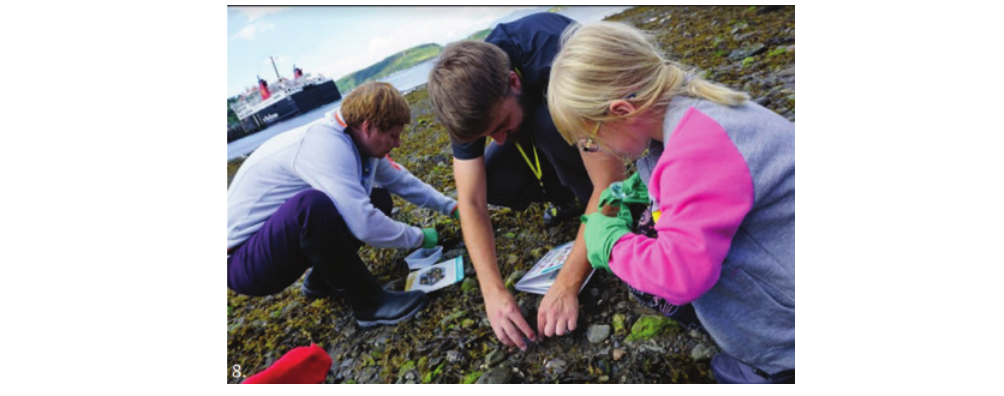
figure 10: Beachcombing (photograph: aquarela